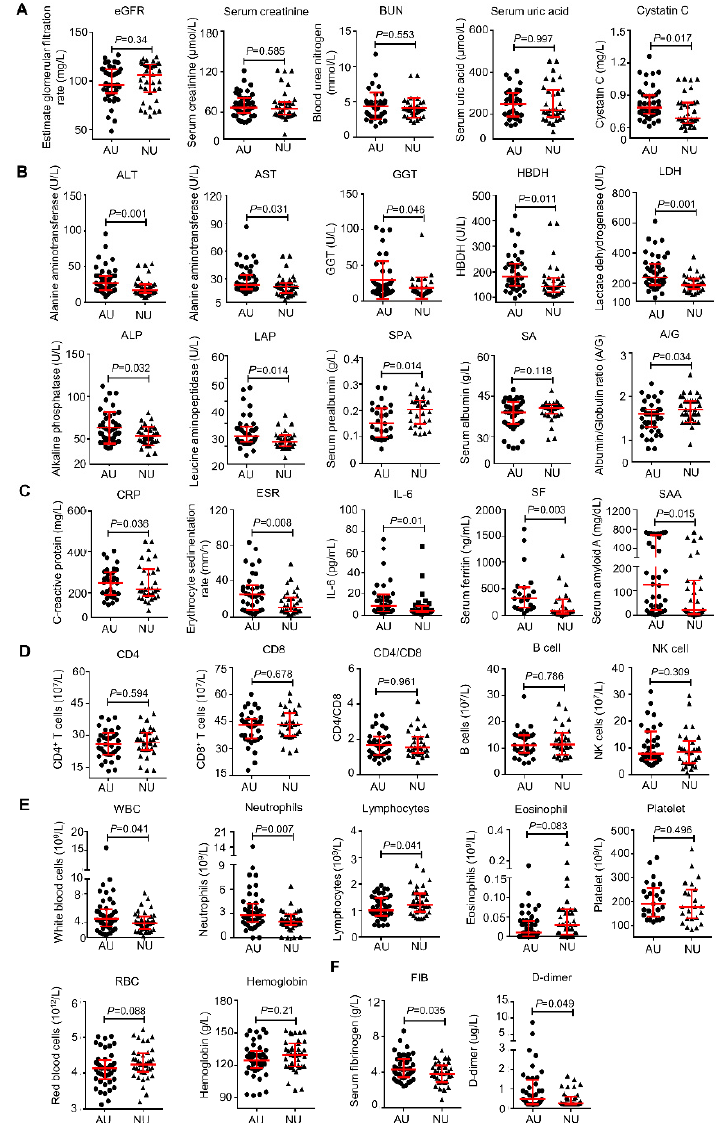
Figure 3. The comparison of laboratory parameters between abnormal urinalysis group and nor- mal urinalysis group. Analysis of renal function ( A ), analysis of liver function ( B ), inflammation ( C ), lymphocytes subpopulations ( D ), blood routine ( E ), and coagulation function ( F ). Abbreviation: GGT, γ -glutamyl transpeptidase; HBDH: α -hydroxybutyrate dehydrogenase.